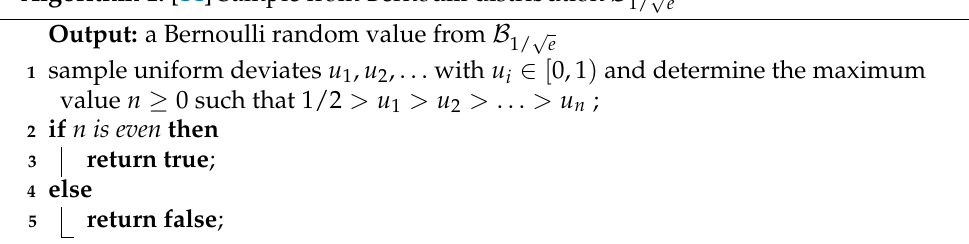
Algorithm 1: [14] Sample from Bernoulli distribution B